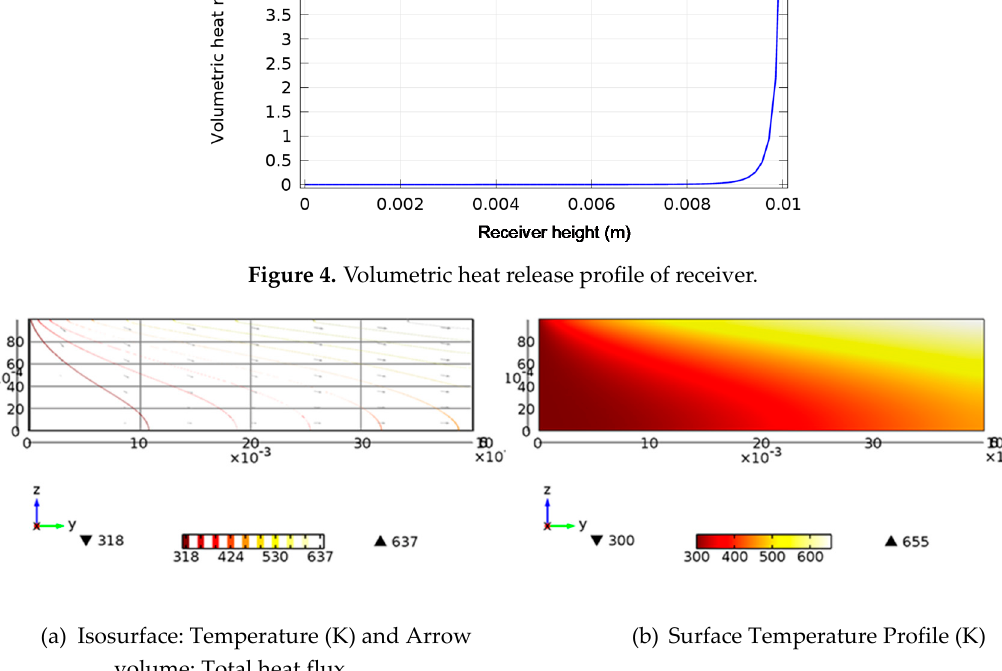
Figure 5. Isothermal contours and temperature profile of the receiver at length 0.4 m.